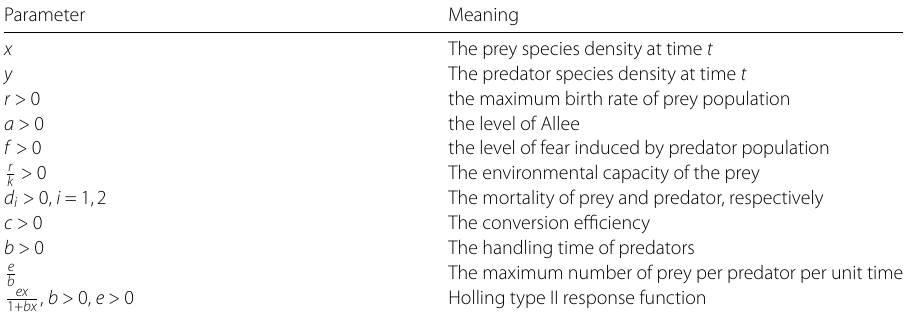
Table 1 Meaning of parameters in model (1.1) and (1.3)